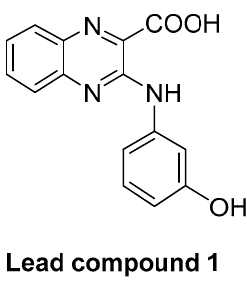
Figure 2. Chemical structure of lead compound 1 [26].